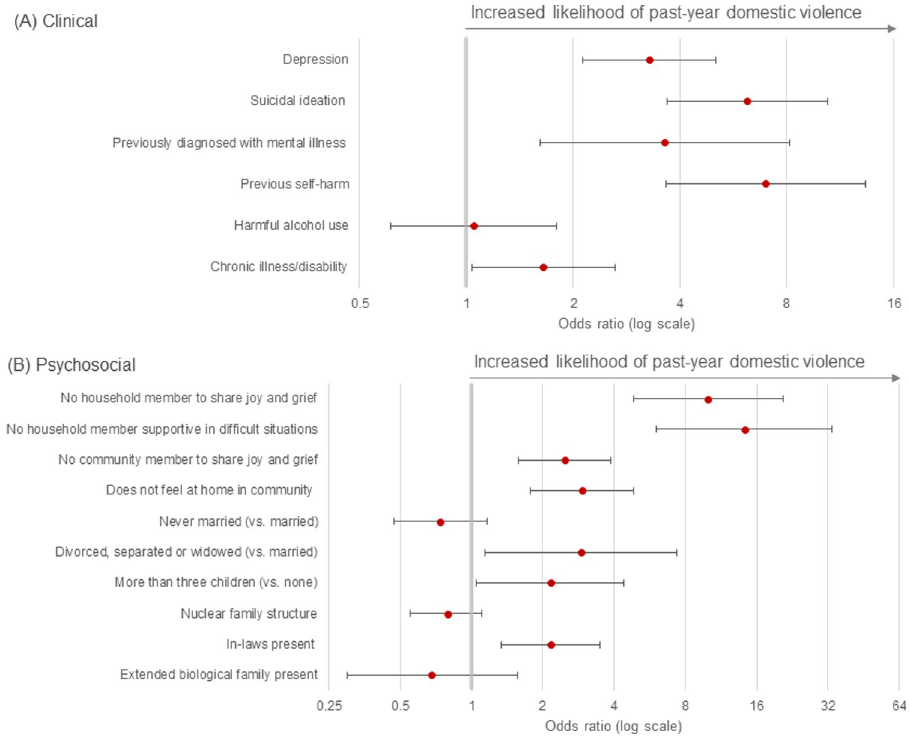
Fig 1. Clinical and psychosocial factors associated with past-year domestic violence, Kandy, Sri Lanka. (A) Clinical correlates of past-year domestic violence, adjusted for age. (B) Psychosocial correlates of past-year domestic violence, adjusted for age and ethnicity. The bold line indicates a null